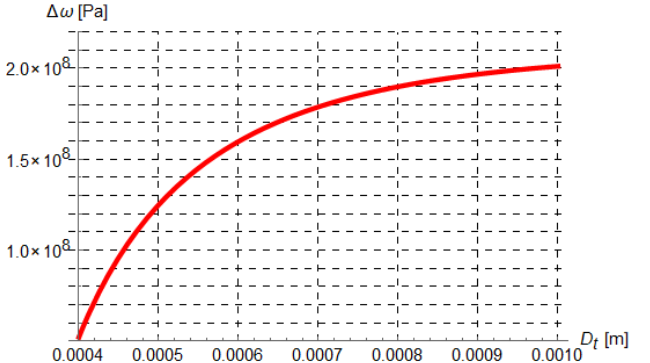
Figure 8. The course of absolute pressure loss ∆ ω , as a function of diameter of the inflow channel to the hole D t .